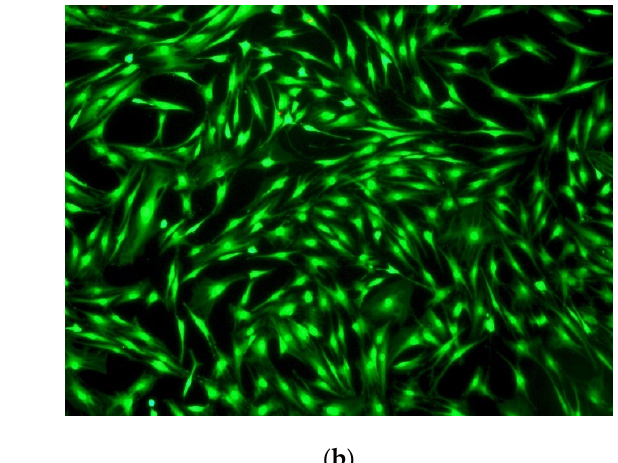
Table 2. MTT test. Indicators of optical density in experimental and control wells.